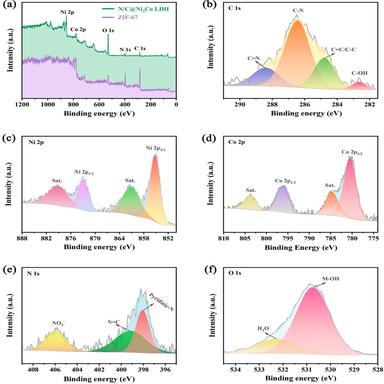
XPS spectra. (a) Survey spectra of ZIF-67 and N/C@Ni-Co LDH. (b-f) C 1 s, Ni 2p, Co 2p, N 1 s and O 1 s of N/C@Ni-Co LDH.